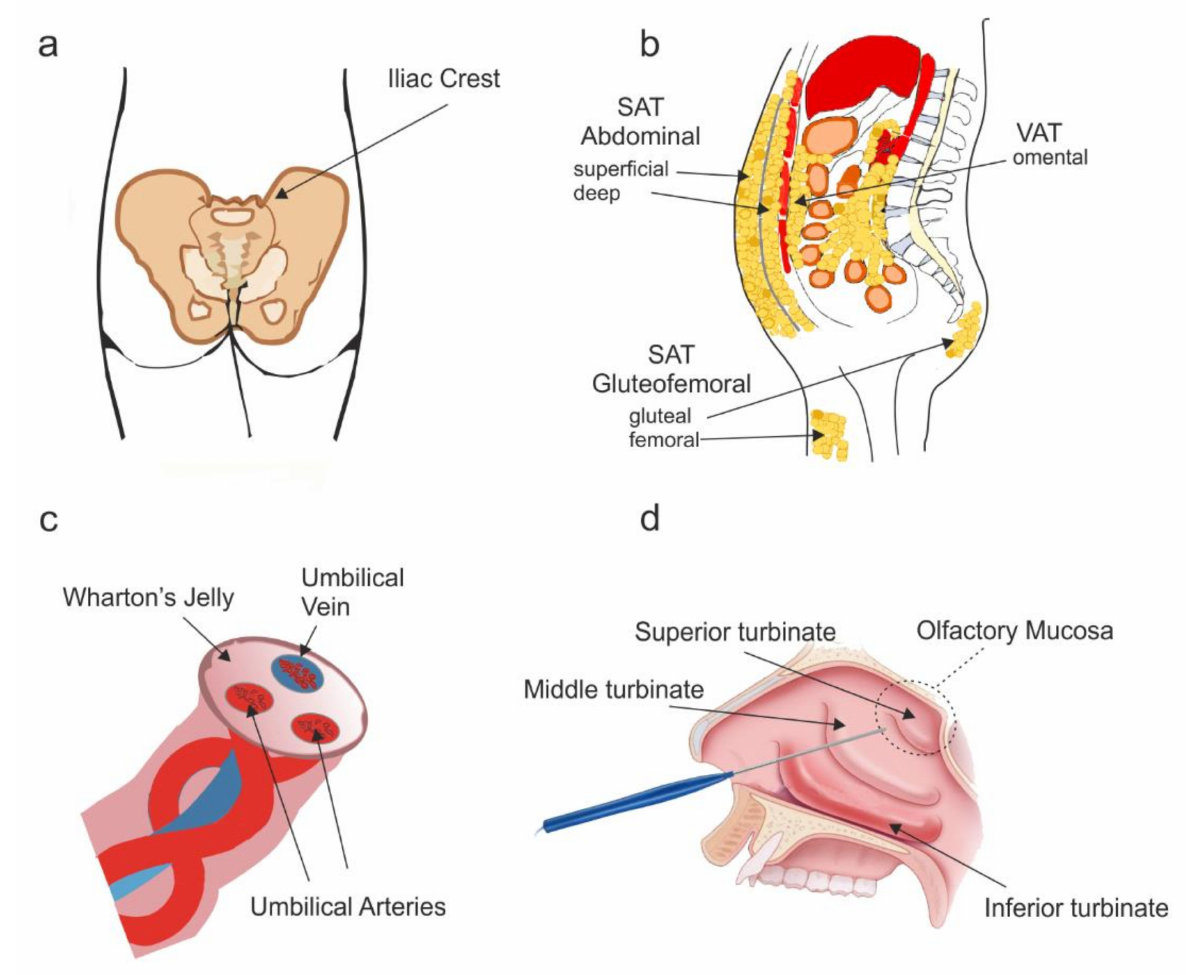
Figure 2. Anatomical location of routinely used MSC types for the treatment of SCI. Schematic diagrams detailing the anatomical locations of the most common MSC types used in clinical trials for the treatment of SCI. ( a ) Bone marrow (BM)-MSCs are routinely harvested from bone marrow aspirated from the iliac crest. ( b ) Adipose-derived (AD)-MSCs are generated from lipoaspirate collected from subcutaneous adipose tissue (SAT), or the omental region of visceral adipose tissue (VAT). ( c ) Umbilical cord (UC)-MSCs can be isolated from whole umbilical cord tissue, Wharton’s jelly, or the umbilical cord vein or arteries. ( d ) Olfactory mucosa (OM)-MSCs can be isolated from the olfactory mucosa which lines the dorsoposterior and superior turbinates and is accessible via the nasal